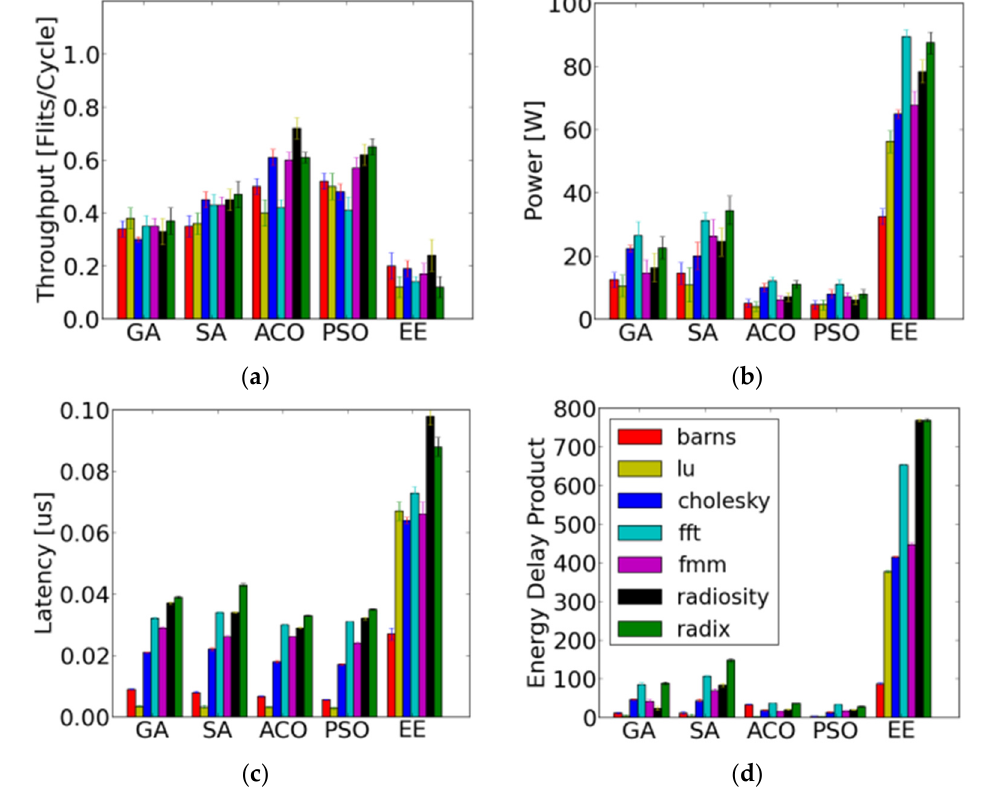
Figure 8. SPLASH-2 [45] benchmarks comparison for 10 × 10 NoC ( a ) throughput, ( b ) power, ( c ) latency and ( d ) energy delay product.